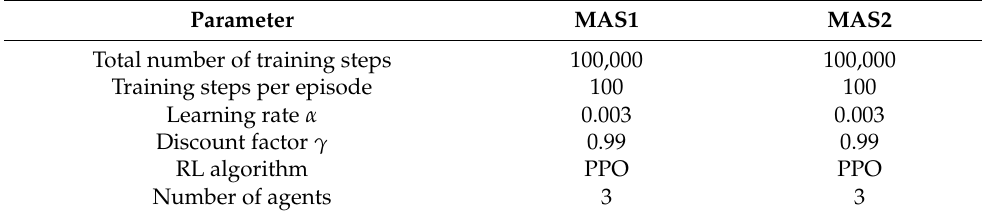
Table 2. Training parameters of MAS1 and MAS2.